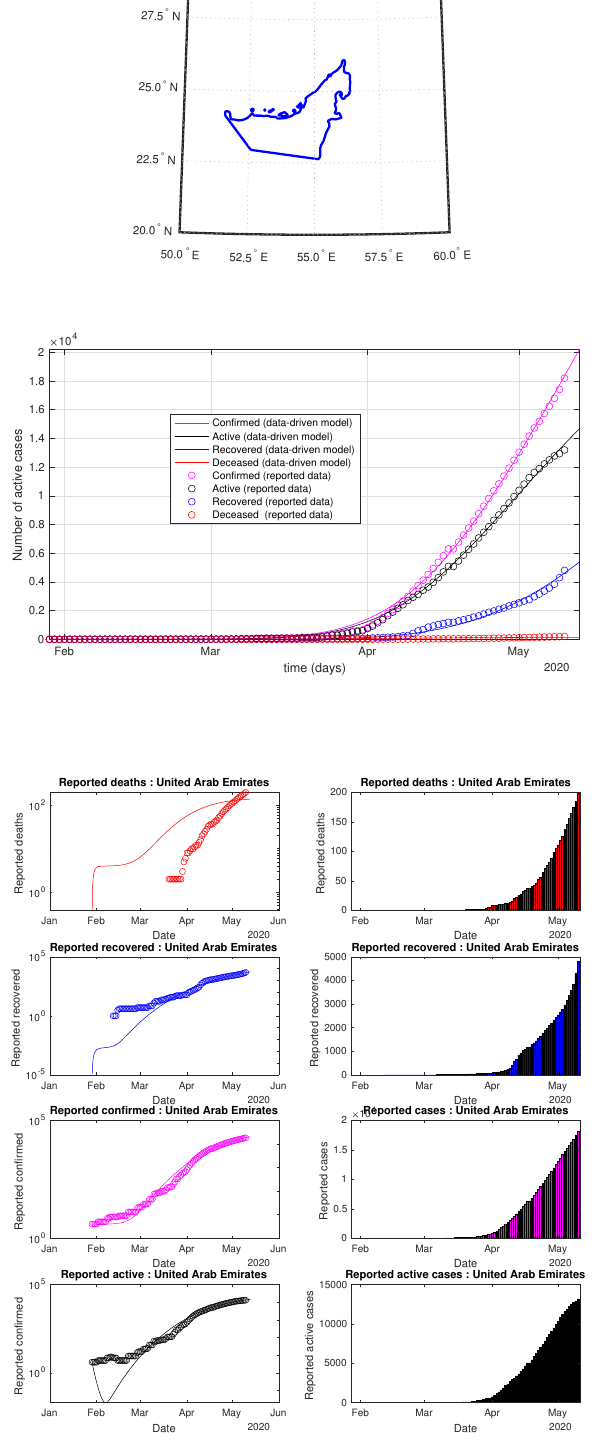
Figure 40. UAE: data of active, recovered, deceased (in circle or bar) vs. model of active, recovered, deceased over time. Tracking the number of active cases. Predictive analytics for the next couple